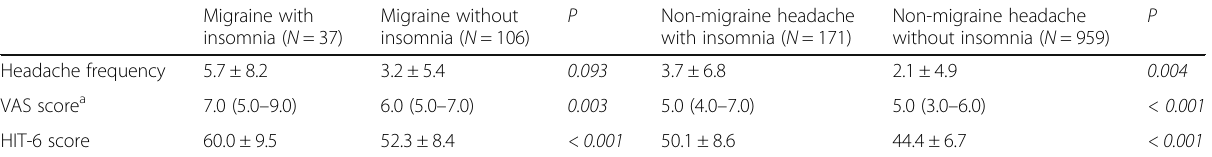
Table 3 Headache frequency, VAS score of headache intensity, and impact of headache in relation to the presence of insomnia among participants with migraine and non-migraine headache P Non-migraine headache Migraine with Migraine without insomnia ( N = 37) insomnia ( N = 106) with insomnia ( N =